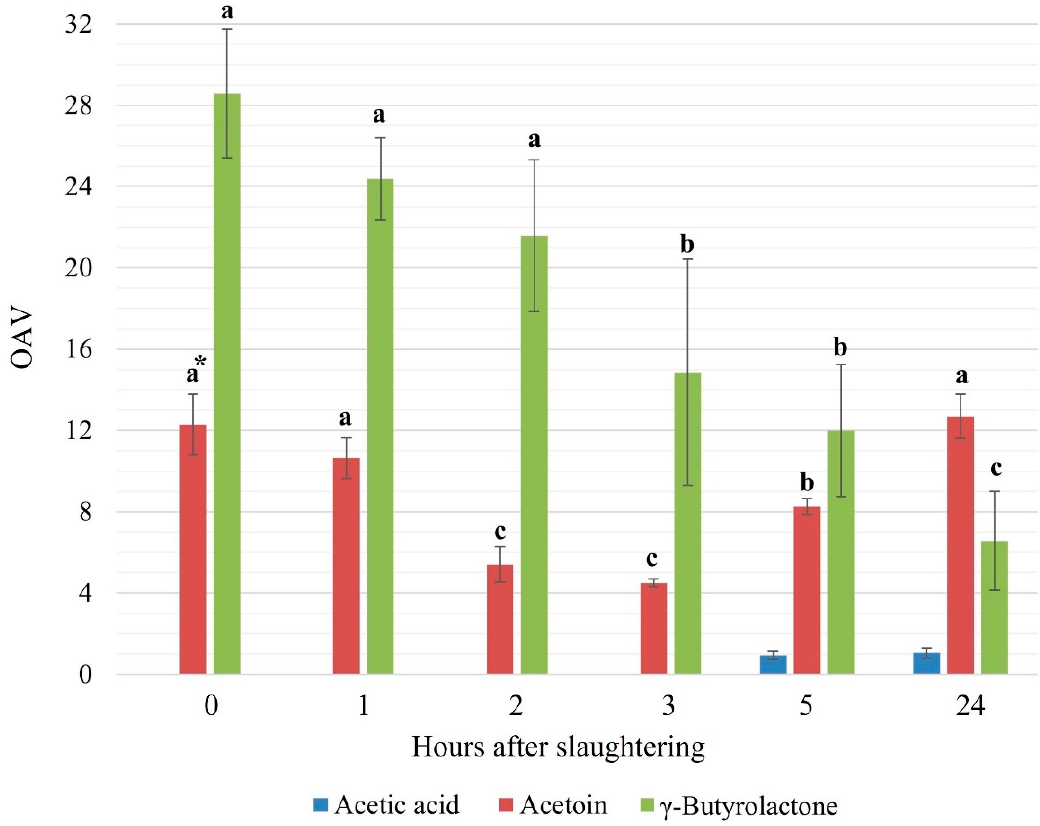
Figure 1. Average OAV for the main volatiles in meat samples at different times (hours) after slaughtering. * Different letters on bars of the same colors represent significant differences at p < 0.05 by Duncan’s multiple range test.